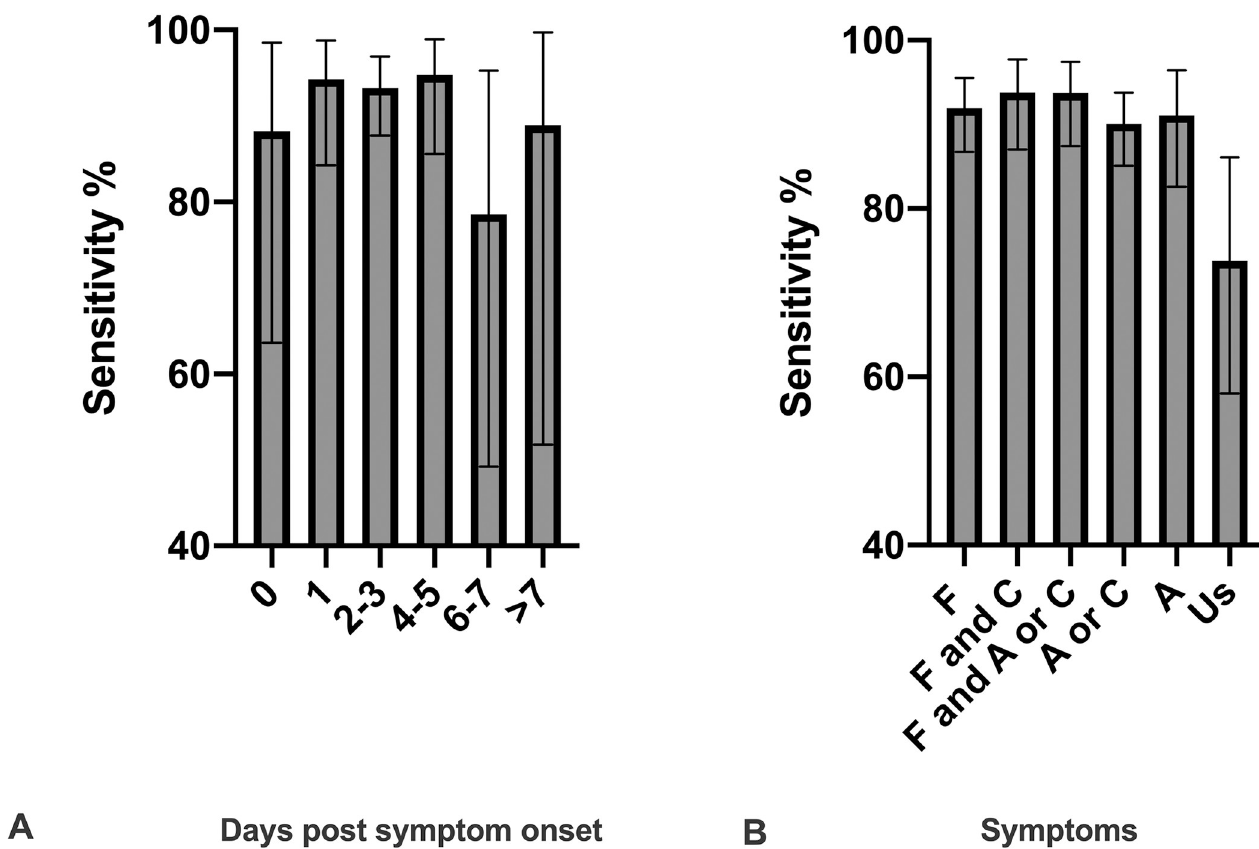
Fig 4. A. Combined SN of the two Ag-RDTs according to days post symptom onset. Number of patients per category: Day 0, n = 17; day 1, n = 53, day 2–3, n = 135; day 4–5, n = 58; day 6–7, n = 14; > 7 days, n = 9). B. Combined SN of the two Ag-RDTs according to symptoms F, fever/chills; C, cough, A, anosmia/ ageusia (loss of smell or taste), Us, unspecific symptoms (all other symptoms excluding fever/chills, cough and anosmia/angeusia). Number of patients per category: F, n = 172; F and C, n = 97; F and A or C, n = 111; A or C, n = 202; A, n = 79; Us, n = 42.